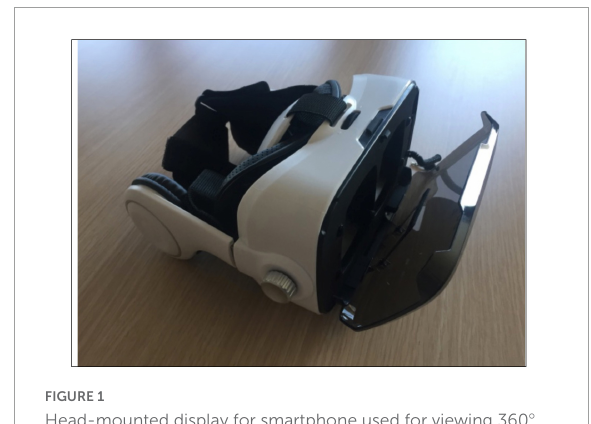
FIGURE1 Head-mounted display for smartphone used for viewing 360 ◦